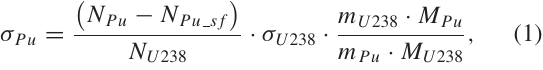
Figure 2. Schematic drawing of the experimental setup for the cross section measurement.